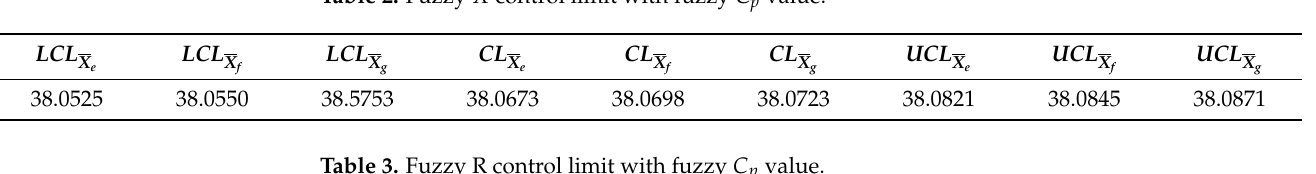
Table 2. Fuzzy X control limit with fuzzy C p value.